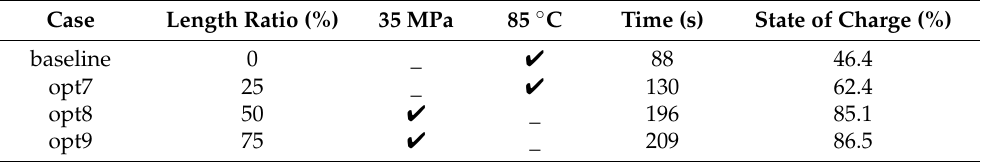
Figure 9. Temperature and velocity contour of hydrogen inside the cylinder at 80 s.